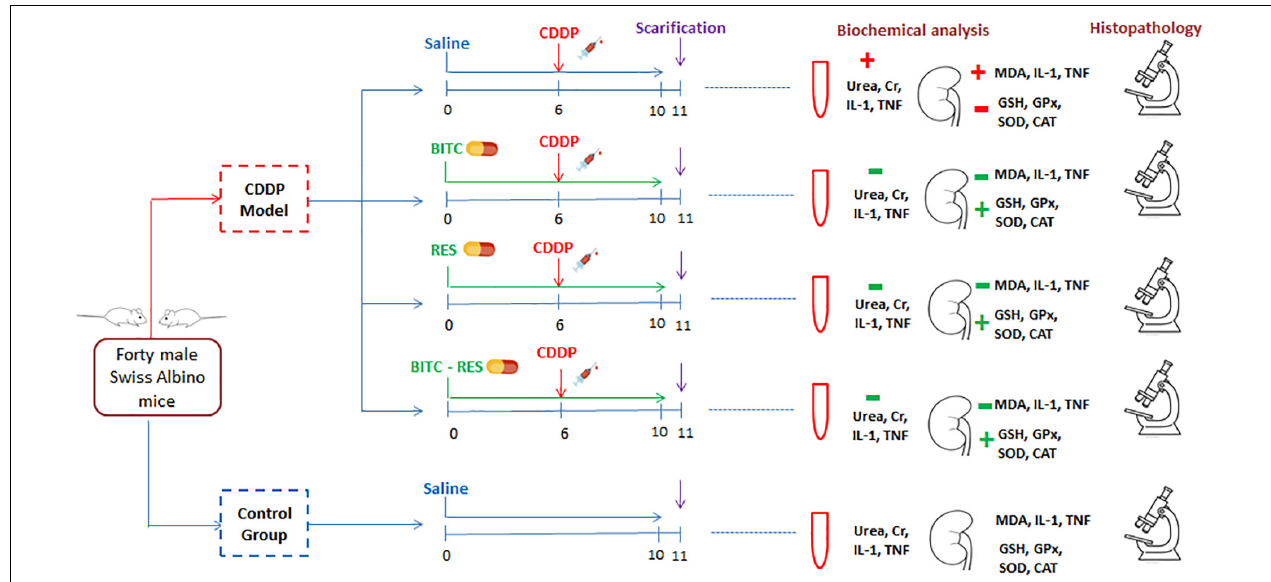
FIGURE 2 | A flow diagram of animal allocation, treatment regimens, and outcome assessment. BITC: benzyl isothiocyanate, CAT: catalase, GPx: glutathione peroxidase, GSH: glutathione, IL-1 β : interleukin-1 β , MDA: malondialdehyde, RES: resveratrol, SOD: superoxide dismutase, and TNF: tumor necrosis